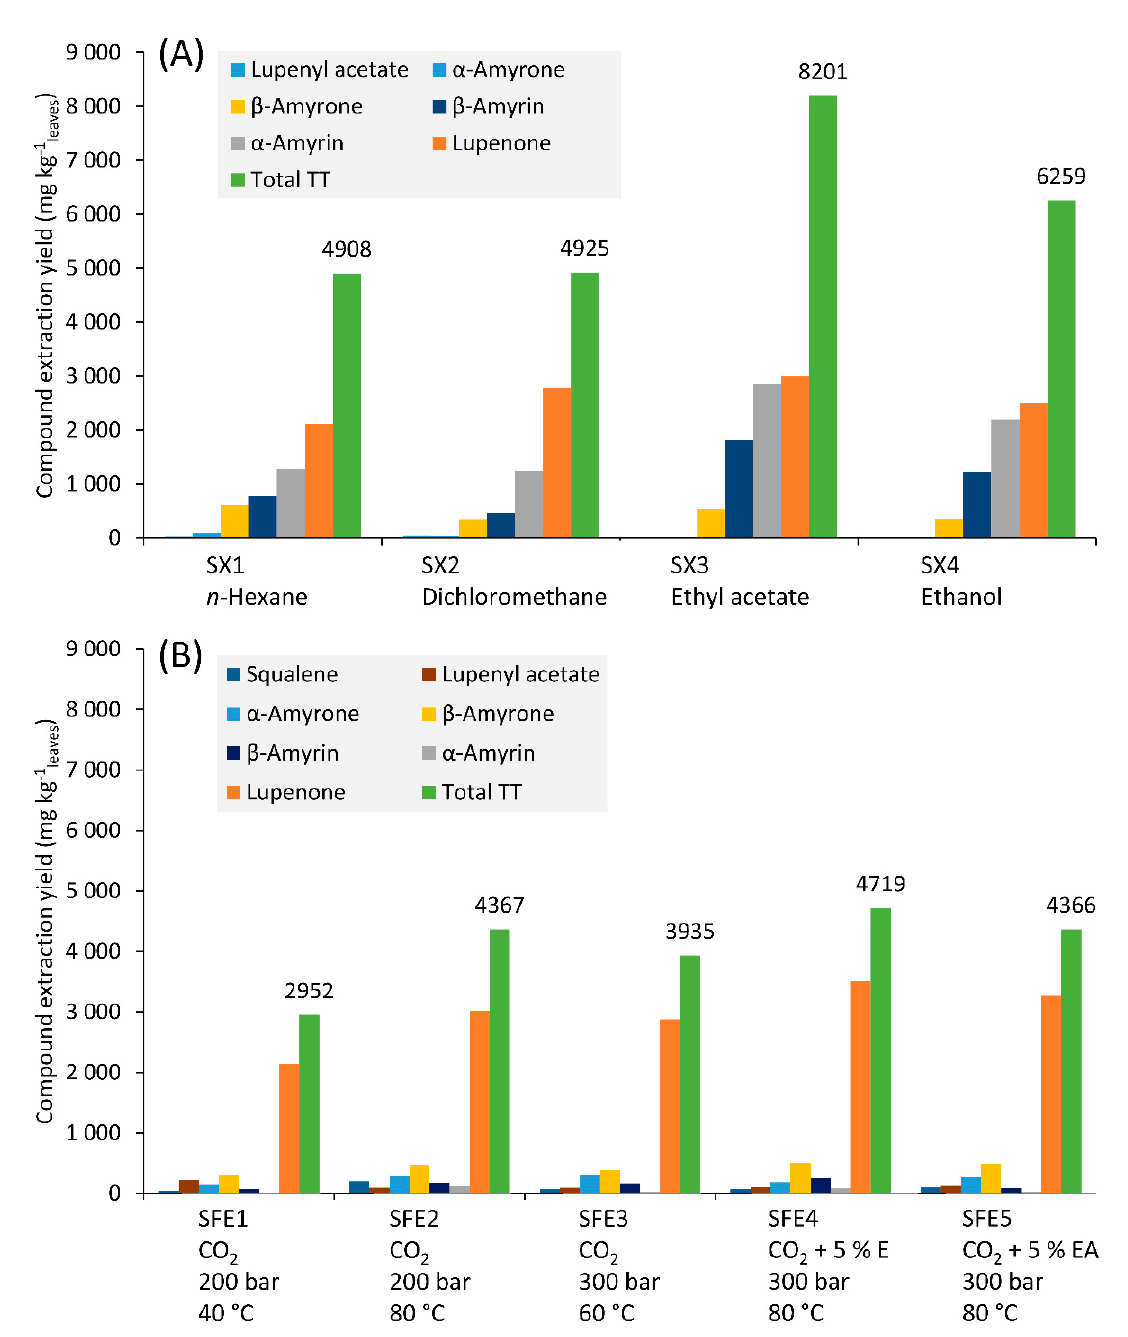
Figure 7. Individual and total triterpenoid (Total TT) extraction yields in: ( A ) Soxhlet extracts using different organic sol- vents, and ( B ) SFE at different conditions of temperature, pressure, and ethanol (E) or ethyl acetate (EA) content as modi- fiers.